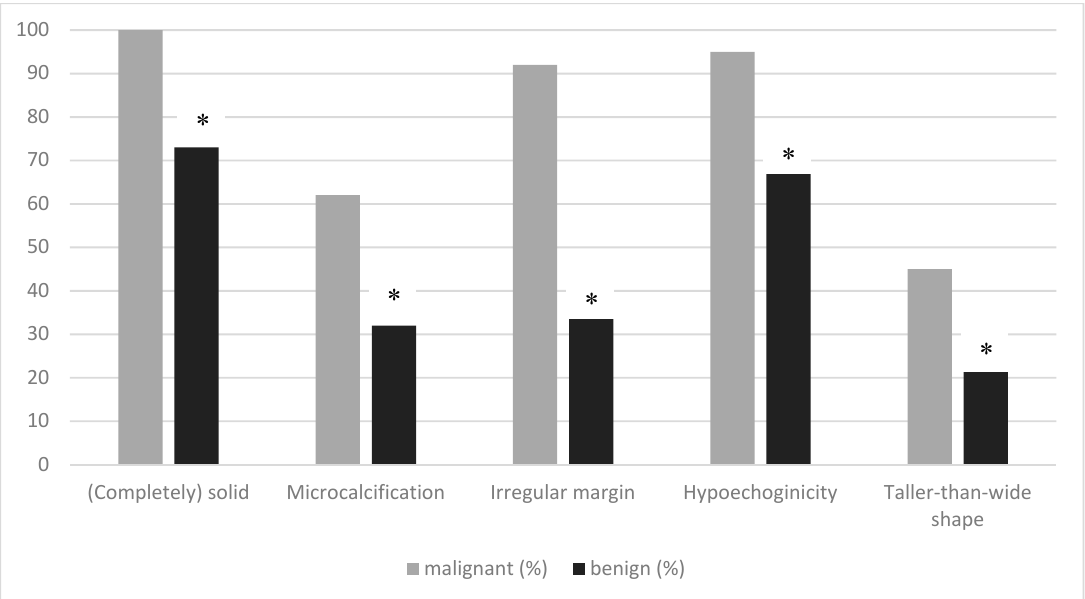
Figure 1. Percentage of various suspicious ultrasound features for the differentiation of malignant from benign thyroid nodules. Univariate analysis showed significant differences between malignant and benign TNs for all suspicious features (* p < 0.01).